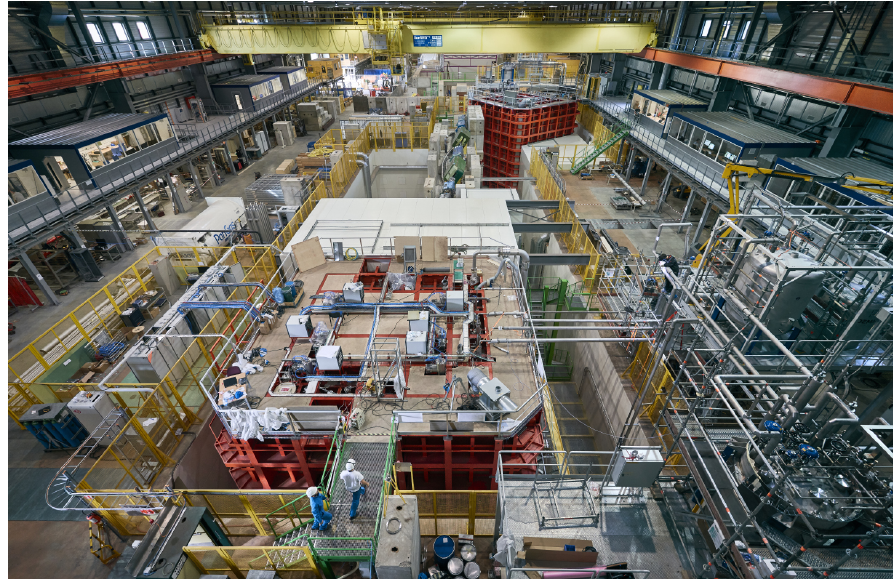
Figure 7. The ProtoDUNE-SP and ProtoDUNE-DP detectors at CERN.